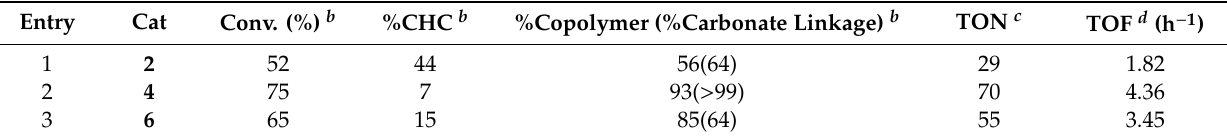
Table 2. Synthesis of poly(cyclohexene carbonate) catalysed by complexes 2 , 4 and 6 a .